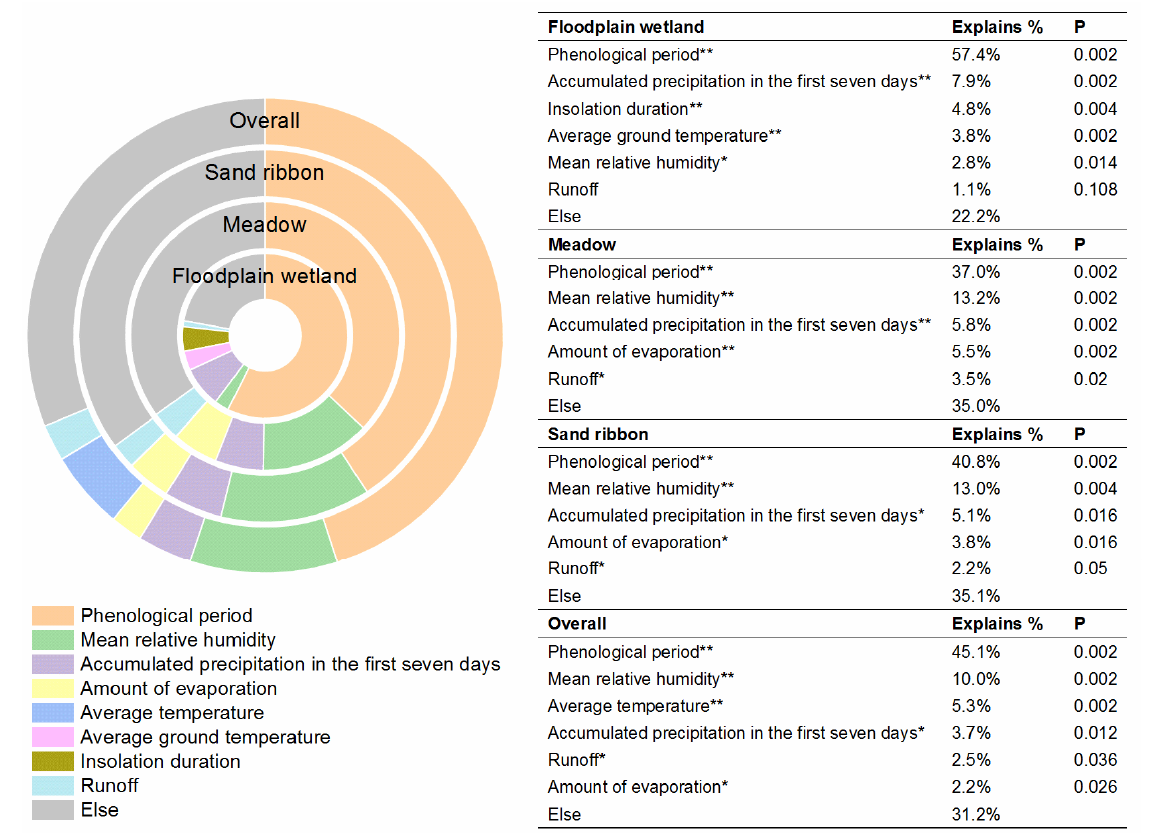
Figure 6. Pie chart of NDVI explanatory power. * and ** represent p < 0.05 and p < 0.01, respectively.